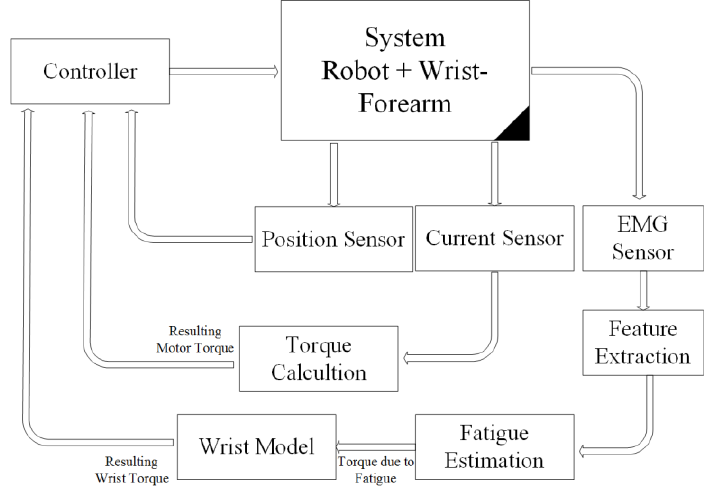
Figure 6. Loaded robot control architecture.